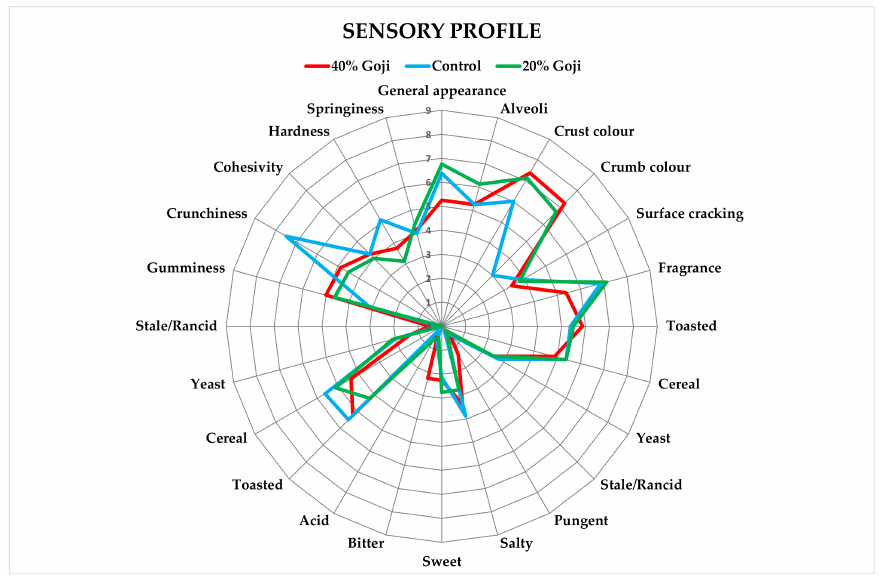
Figure 4. Comparison between control ciabatta and ciabatta enriched with goji